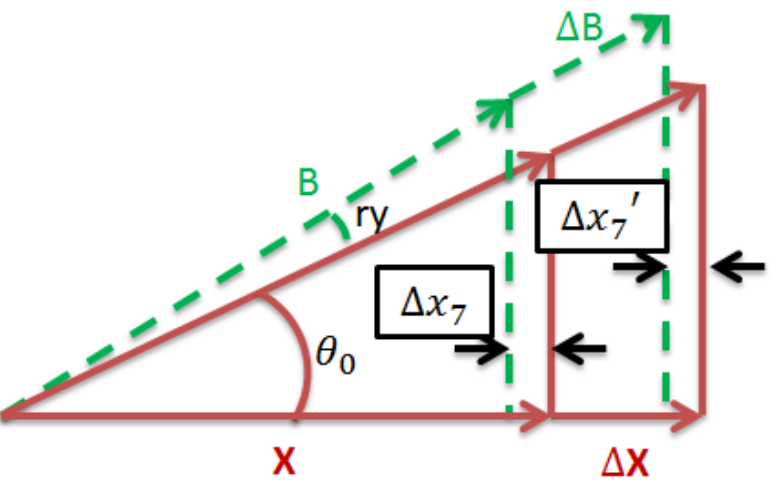
Figure 15. Ballscrew B rotation error.